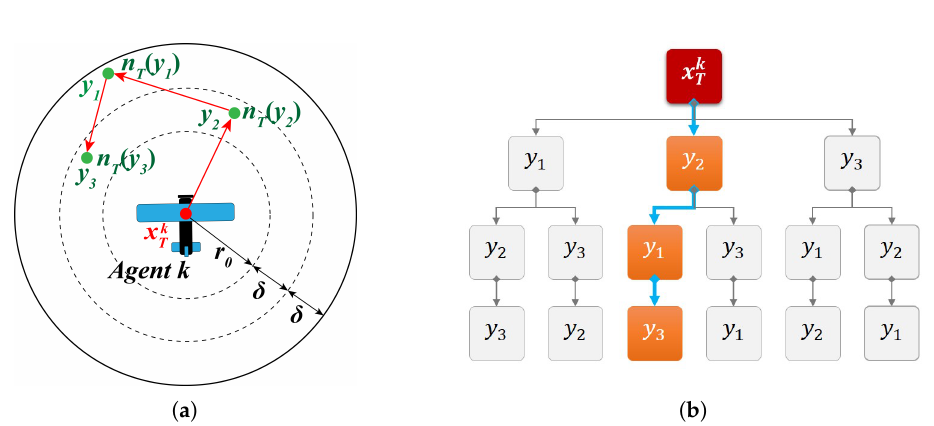
Figure 4. Schematic of the next goal point g x k determination process for agent k : ( a ) increase the T + 1 radius of the search circle until h numbers of sample points are found; ( b ) construct a tree associated with the found points y j and then select a particular path (red arrows) that has a minimum